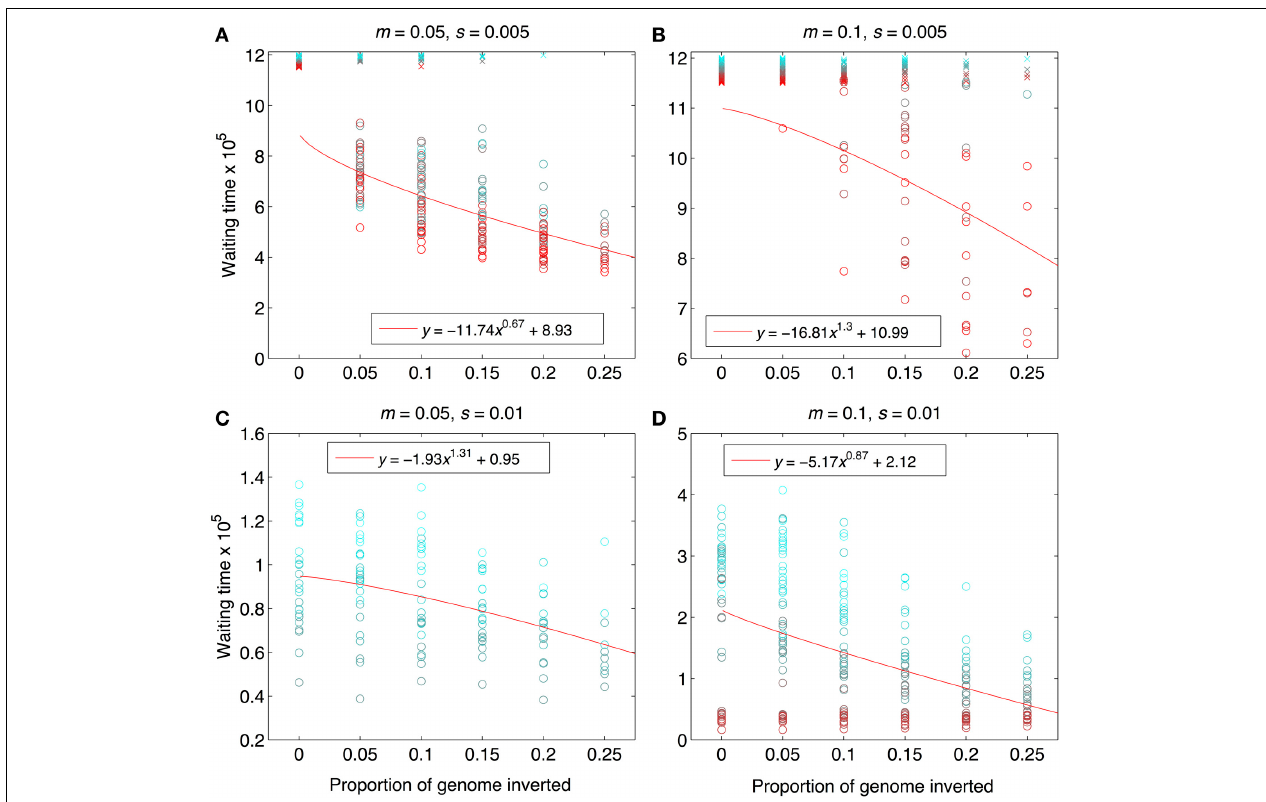
FIGURE 4 | Waiting times to reach the designated barrier strength, m / m e ≥ 500. Data are from the same set of simulation runs as Figures 2 , 3 , and the interpretation of the symbols and the solid, red lines are the same. The “waiting time” was calculated as the number of generations that elapsed between the end of the period of allopatry